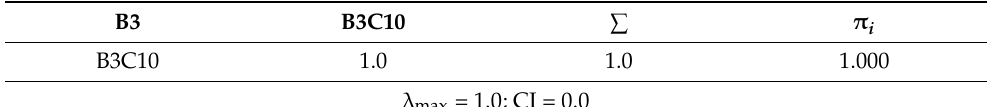
Table 9. Matrix of pairwise comparisons (Level